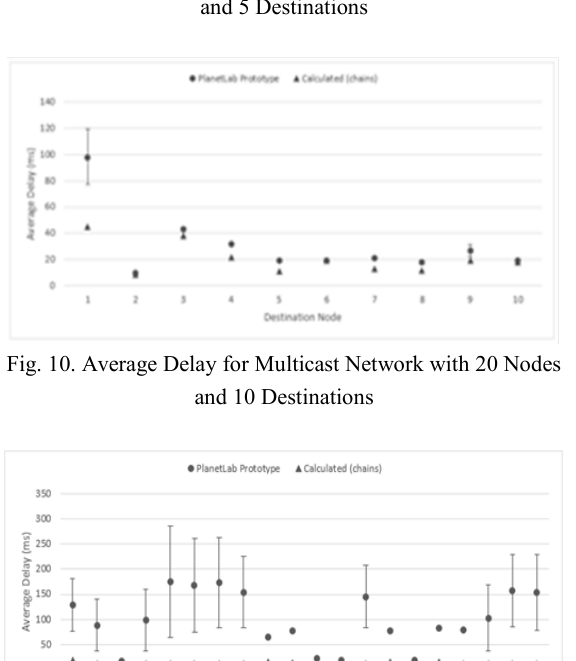
Fig. 9. Average Delay for Multicast Network with 10 Nodes and 5 Destinations